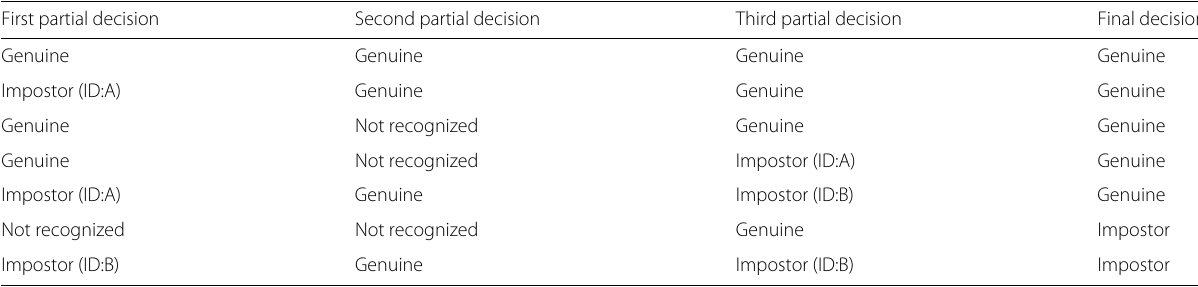
Table 1 Combination possibilities of partial decisions First partial